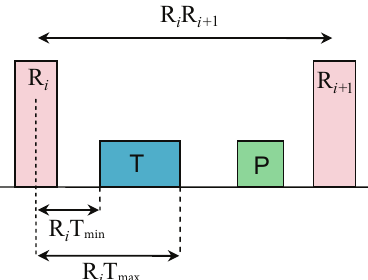
Figure 8. Search regions for T waves in terms of time occurrence with respect to the current R peak ( R ) and the next R peak ( R i interval between the T wave and current R peak and R between the T wave and the current R